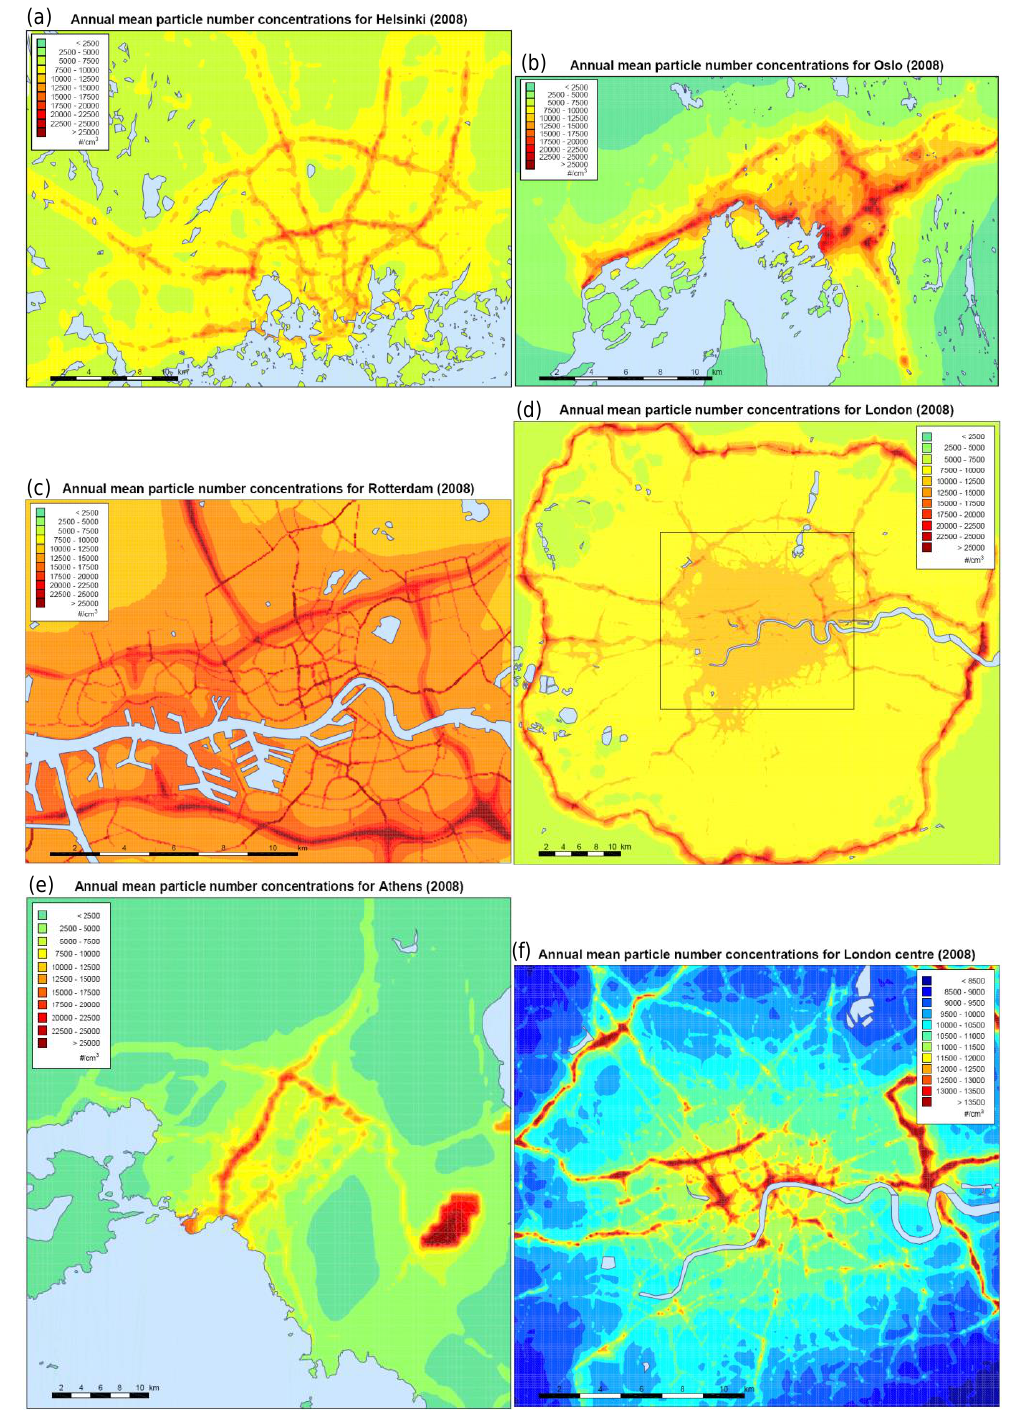
Figure 8. The predicted spatial distributions of particle number concentrations in the target cities in 2008. The cities in the top row are Helsinki and Oslo, in the middle row Rotterdam and London, and in the bottom row Athens and the centre of London (the location of which is shown in d as a rectangle). The concentration unit in all the legends is particles per cm 3 . The legends are identical for (a) – (e) , but different for (f) (the centre of London). The water areas are presented in blue